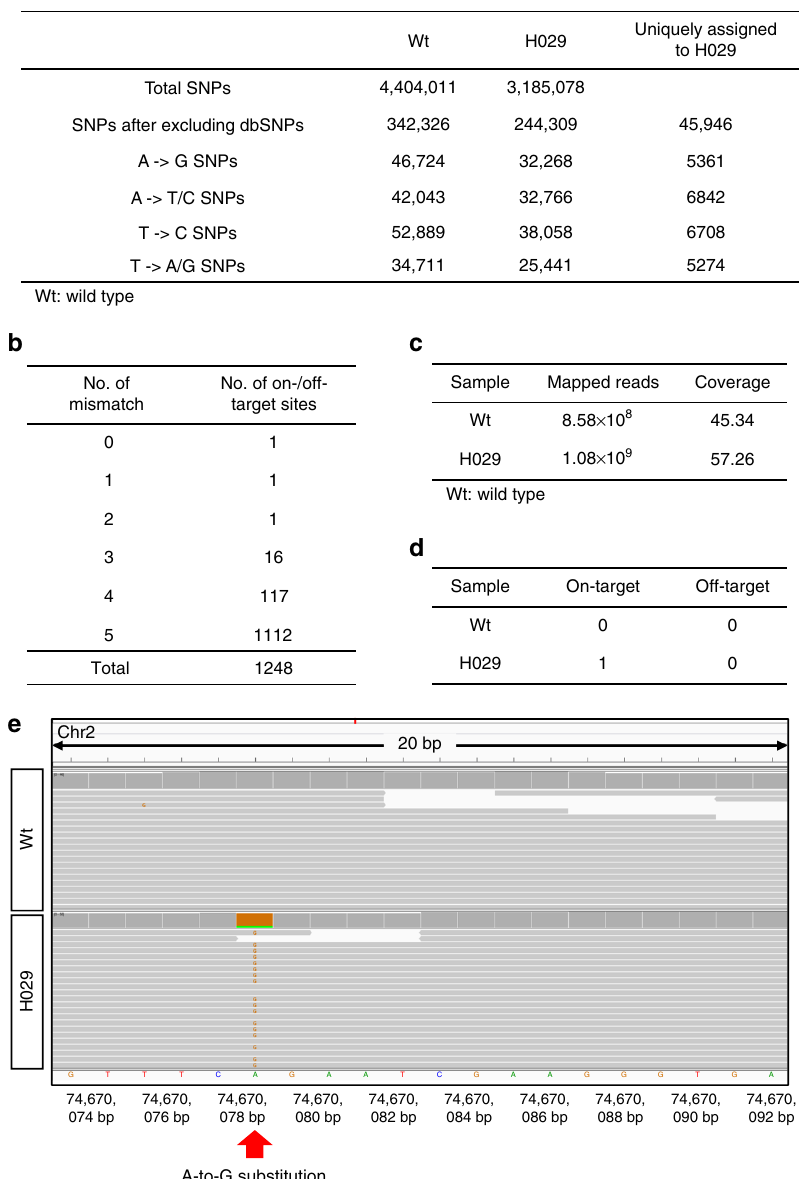
Fig. 4 Whole-genome analysis of Hoxd13 (H029) mutant and wild-type (Wt) mice. a Summary of genome sequencing analysis. A Hoxd13 mutant mouse (H029) and a wild-type mouse (Wt) were sequenced separately using Illumina HiSeq X Ten. A total of 4,404,011 and 3,185,078 SNPs were identi fi ed for H029 and Wt, respectively. After fi ltering out dbSNP (naturally occurring variants in the SNP database), 45,946 SNPs were obtained over the H029 genome. The unwanted base substitutions (A → T/C SNPs, T → A/G SNPs) were excluded next. Then the sequences at the remaining SNP sites were compared with all on-/off-target sequences (20 bp). b Summary of on-/off-target site information. A total of 1248 sites, including 1 on-target site and 1, 1, 16, 117, and 1112 off-target sites with 1, 2, 3, 4, and 5 mismatch/es, respectively, were analyzed. c Summary of the whole-genome sequencing. d Summary of off-target analysis. After comparing the sequences at the remaining SNP sites with the 1248 on-/off-target sequence (20 bp), the A-to-G substitution was only detected within the on-target sequencing in H029. e Con fi rmation of the on-target mutation by the analysis of whole-genome sequencing. Red arrow indicates the A-to-G substitution within 20 bp on-target sequence in